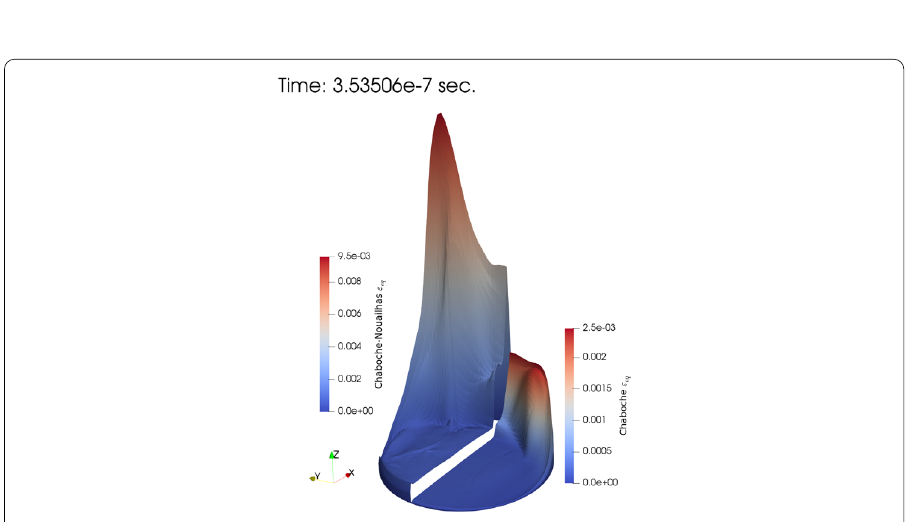
Fig. 23 Cumulated viscoplastic strain ε eq ≡ p in the inclusion at time 3 . 35 × 10 − 7 s, computed with Chaboche (right) and Chaboche–Nouailhas’ (left) viscoplastic constitutive models. Isovalues have been warpped according to the magnitude of ε eq with the same scale factor 0.2